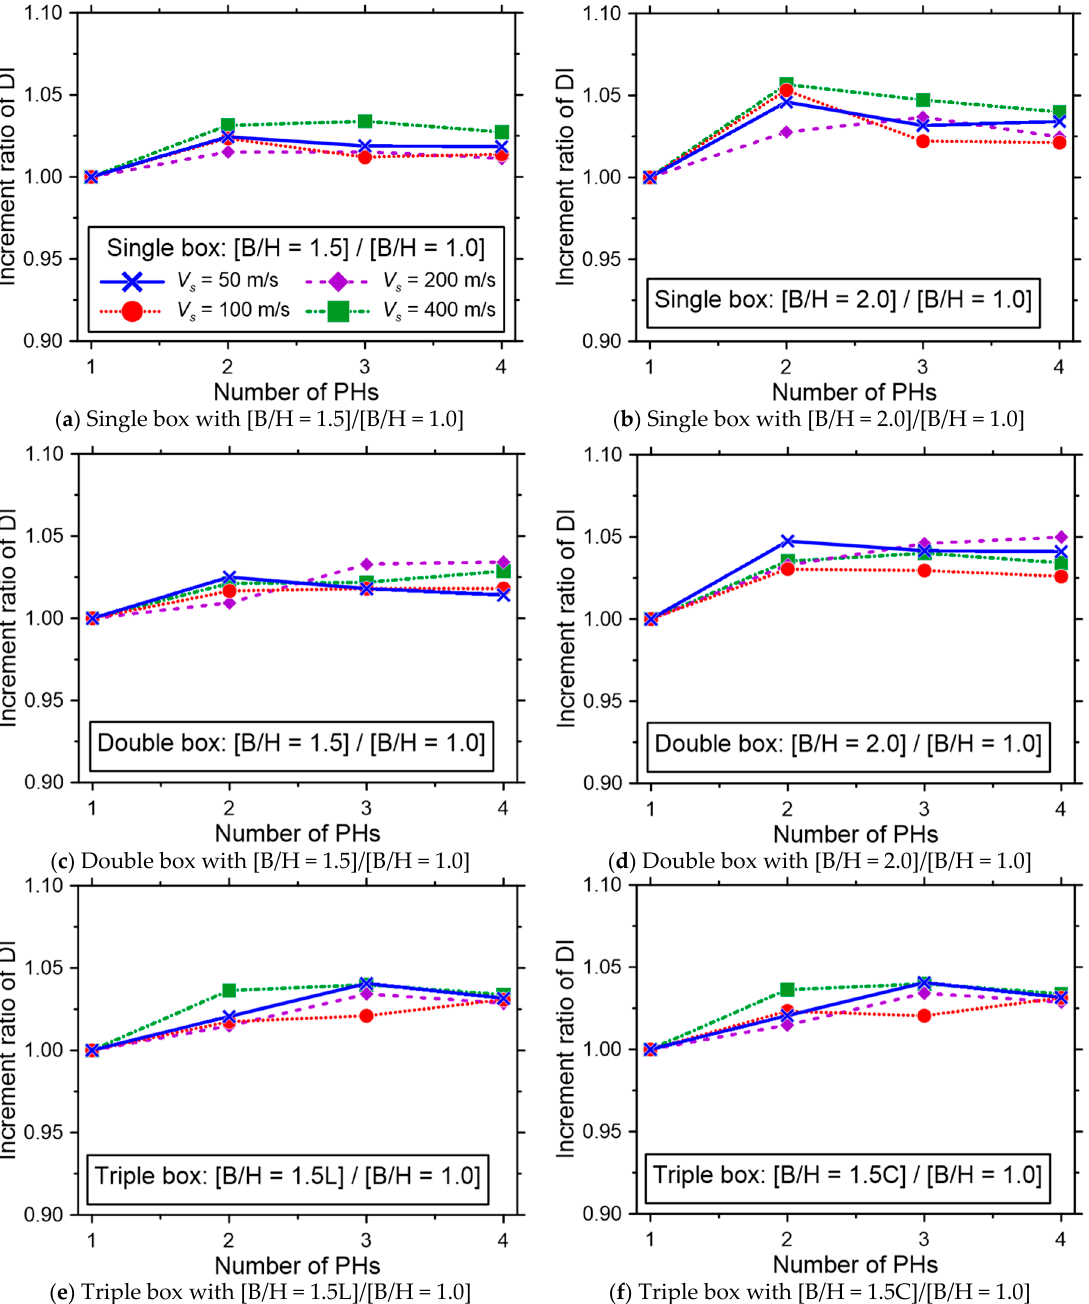
Figure 9. Increment ratio of DI with B / H vs. number of plastic hinges (PHs) of box tunnels for various shear wave velocities ( V s ) values.